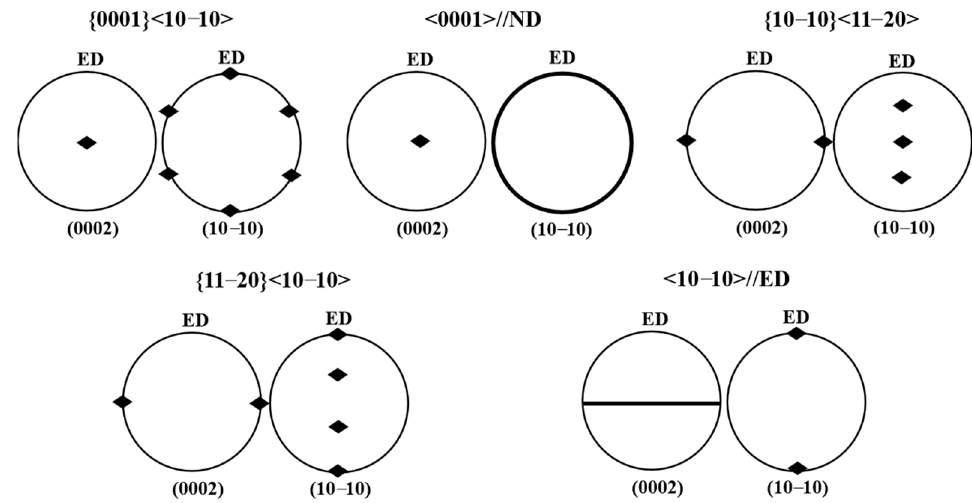
Figure 8. Five typical texture components exist in rectangular extrusion Mg alloy sheet.